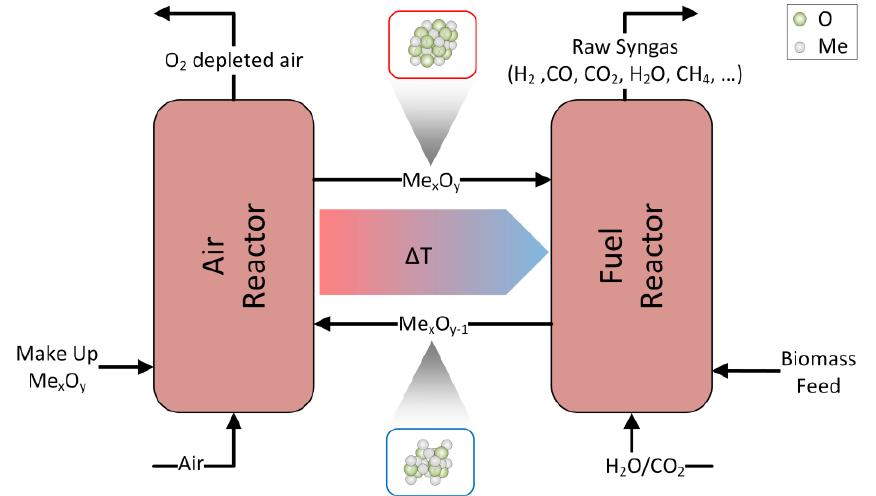
Figure 1. Schematic of chemical looping gasification (CLG) process.